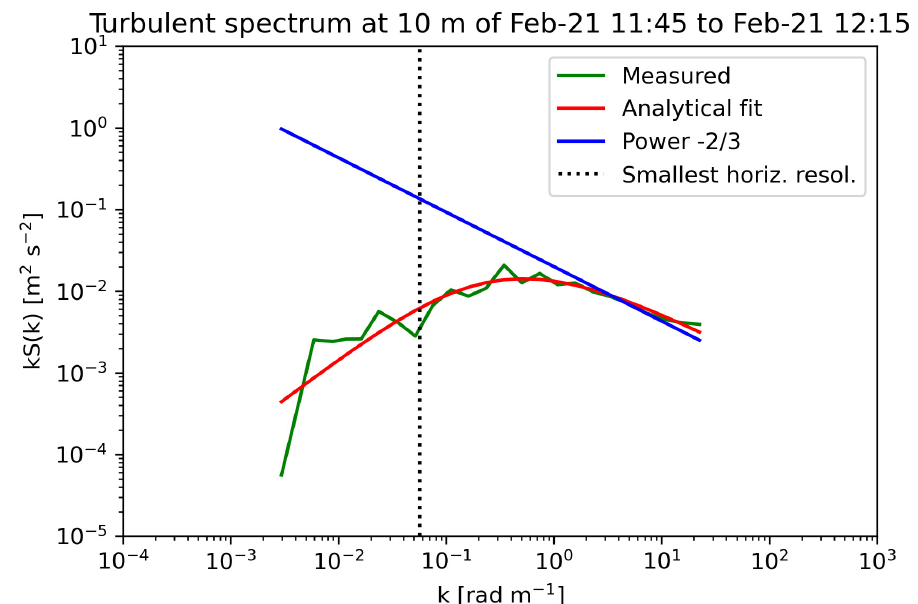
Figure A1. Example of an observed spectrum at 10 m agl and the fit with the model from [67] (matching to the last entry of Table A1). The abscissa is the wavenumber (in rad m − 1 ), and the spectrum energy is in m 2 s − 2 . The green line represents the observed spectrum (values averaged on wavenumber bins), and the red line is the fit from [67]. The blue line is the − 2/3 power law. The dotted line indicates the wavenumber value corresponding to the size of the horizontal cell in the finest simulation domain.